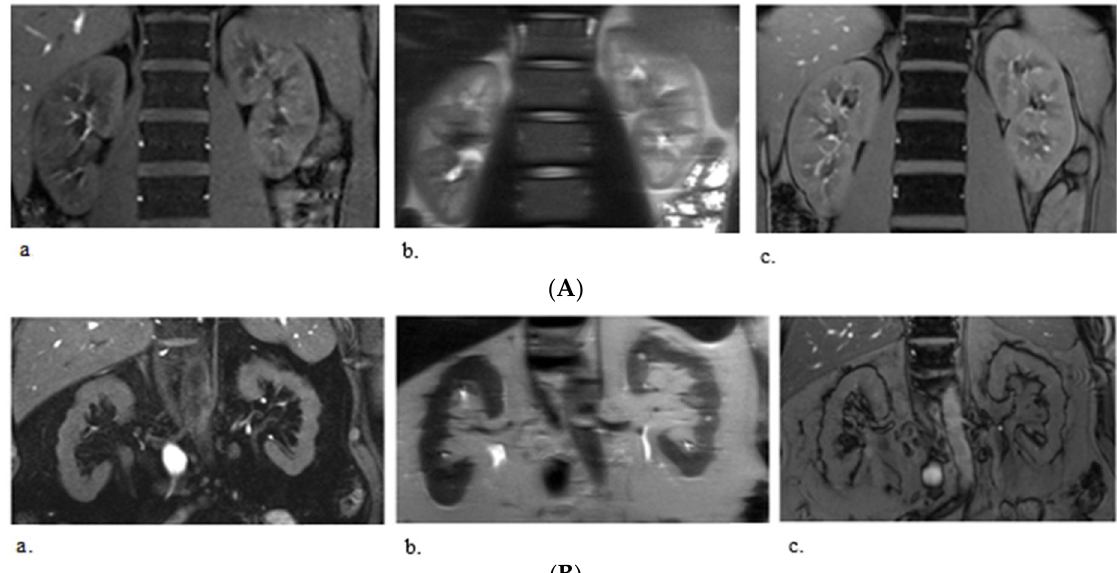
Figure 1. Examples of T1, T2, and T2* MRI in ( A / a ) 35-year-old, healthy man with an estimated GFR of 115 mL/min/1.73 m 2 , and ( B / a ) 78-year-old man with DKD and an eGFR of 22 mL/min/1.73 m 2 . In both subjects, different acquisitions were performed, with respectively ( a ) T1 FLASH, ( b ) T2 HASTE, and ( c ) T2*